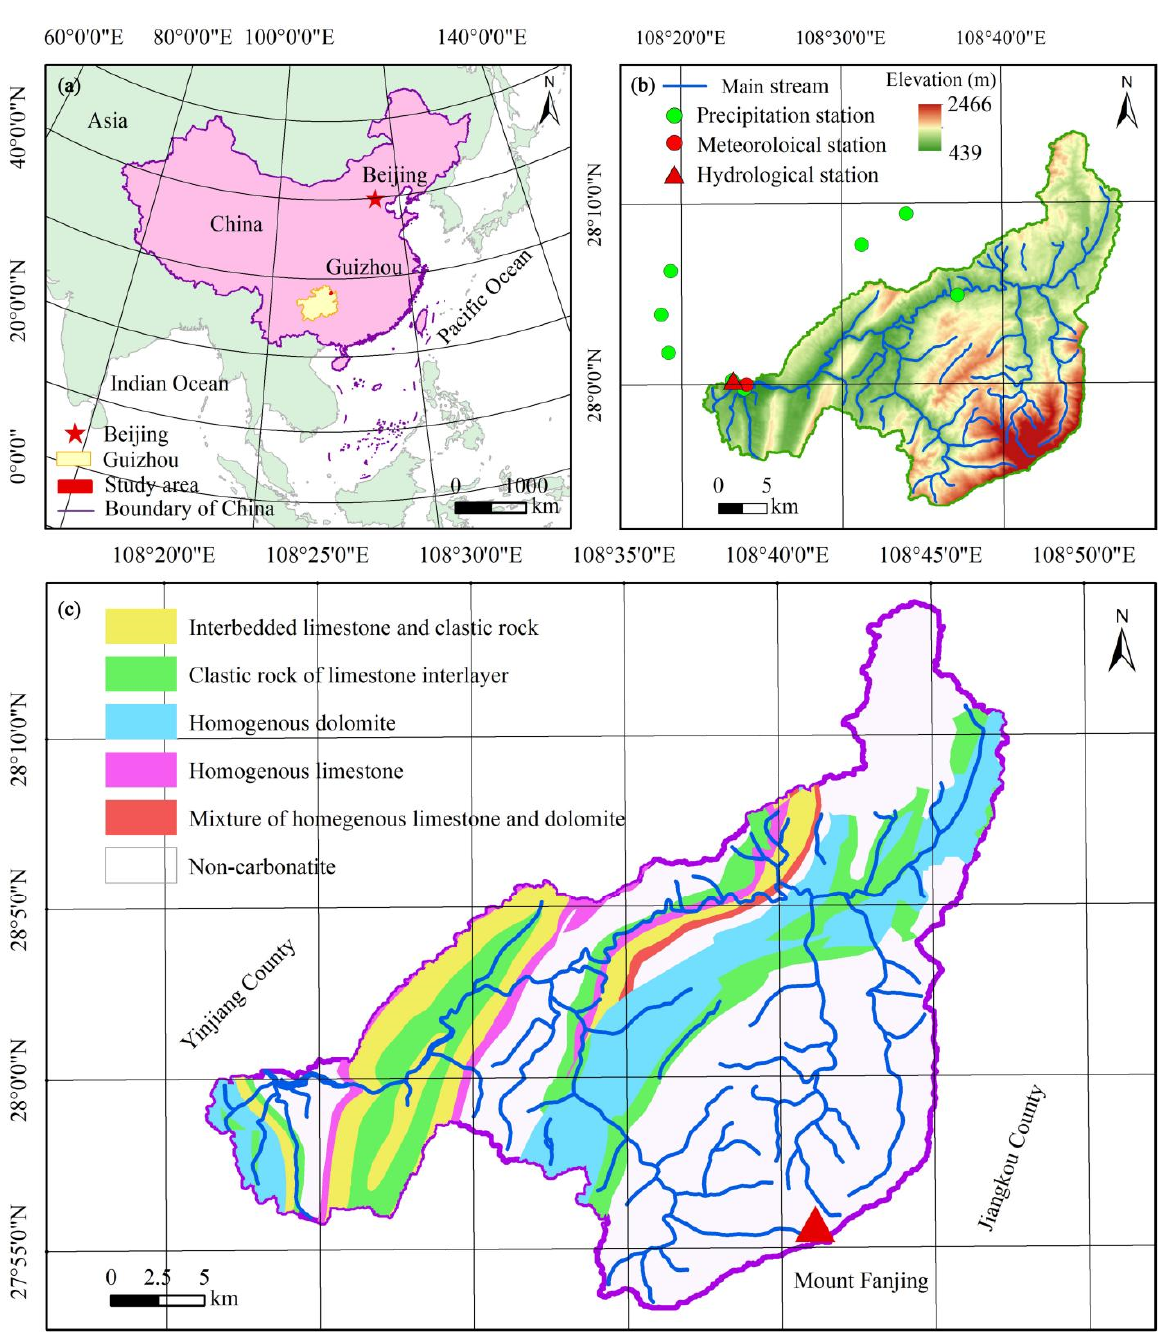
Figure 1. Location and overview of the study area. Study area location in China ( a ), topography ( b ) and lithology ( c ) in Yinjiang River watershed.